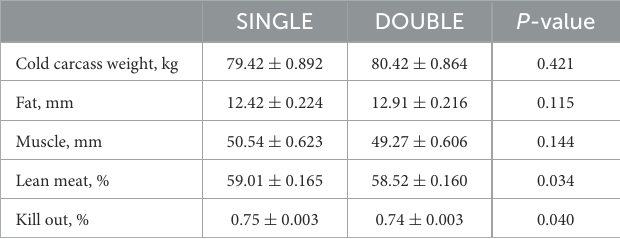
TABLE 6 Differences (LS means ± SE) between treatments in carcass quality at slaughter.